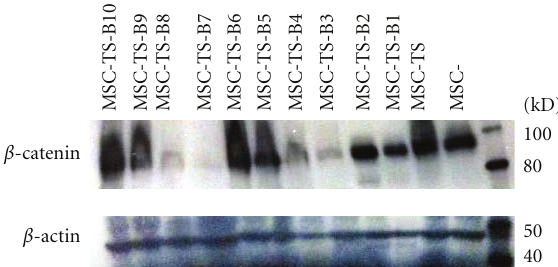
Figure 1: β -catenin protein expression was confirmed by western blot, with β -actin serving as a loading control. Lane 1: hMSC. Lane 2: hMSC-TS. Lane 3–12: hMSC-TSB clones 1 through